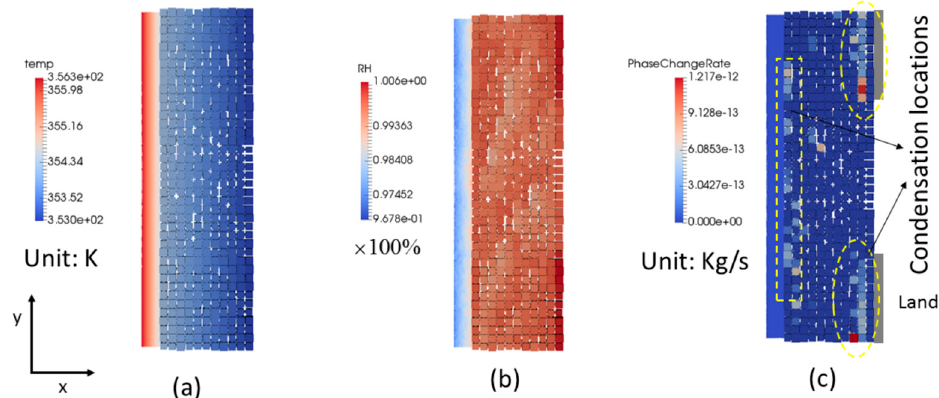
Figure 5. Contours of temperature ( a ), relative humidity ( b ), and liquid water generation rate ( c ) initially in case 1. The operating parameters are given in Table 1.